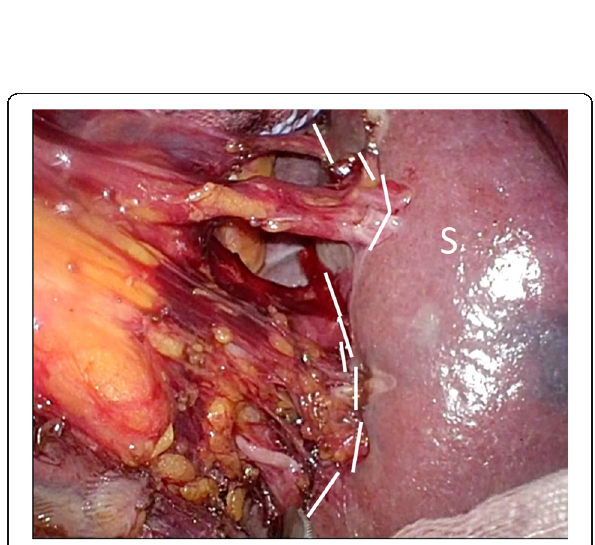
Fig. 4 Intraoperative image showing the dissected line (broken line) just at the point of the splenic hilum, and the short gastric vessels in the gastrosplenic ligament were preserved as much as possible to supply the remnant stomach. S, spleen